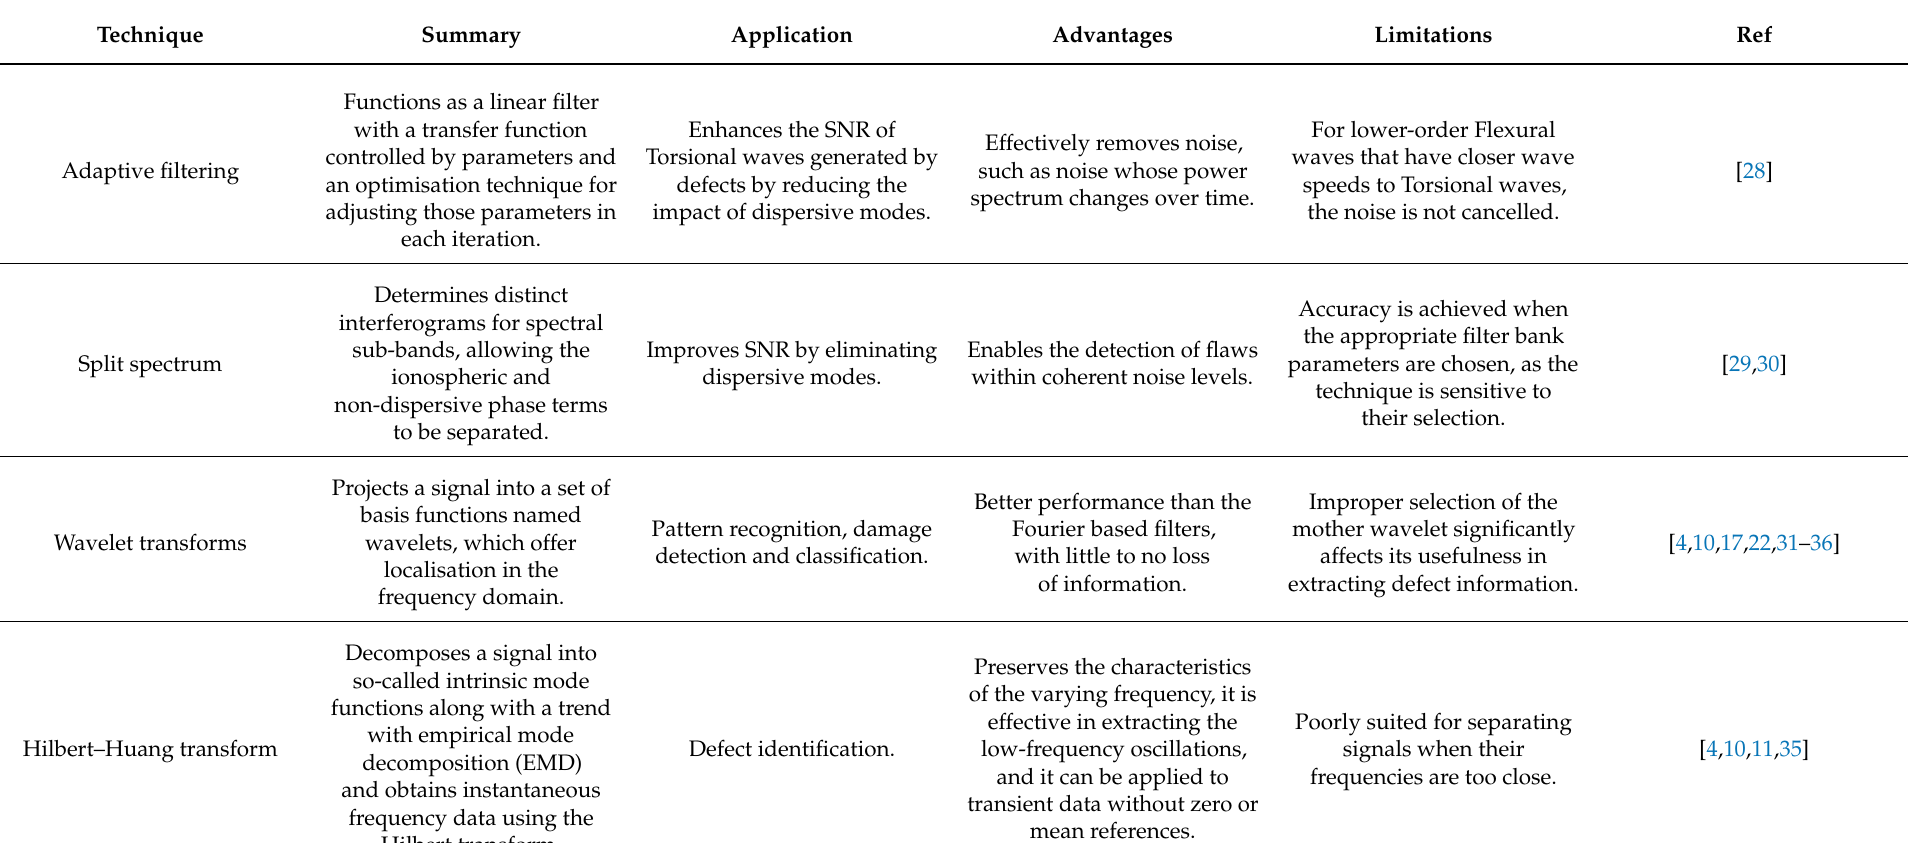
Table 1. Overview of the signal processing techniques that have been commonly used in ultrasonic guided wave